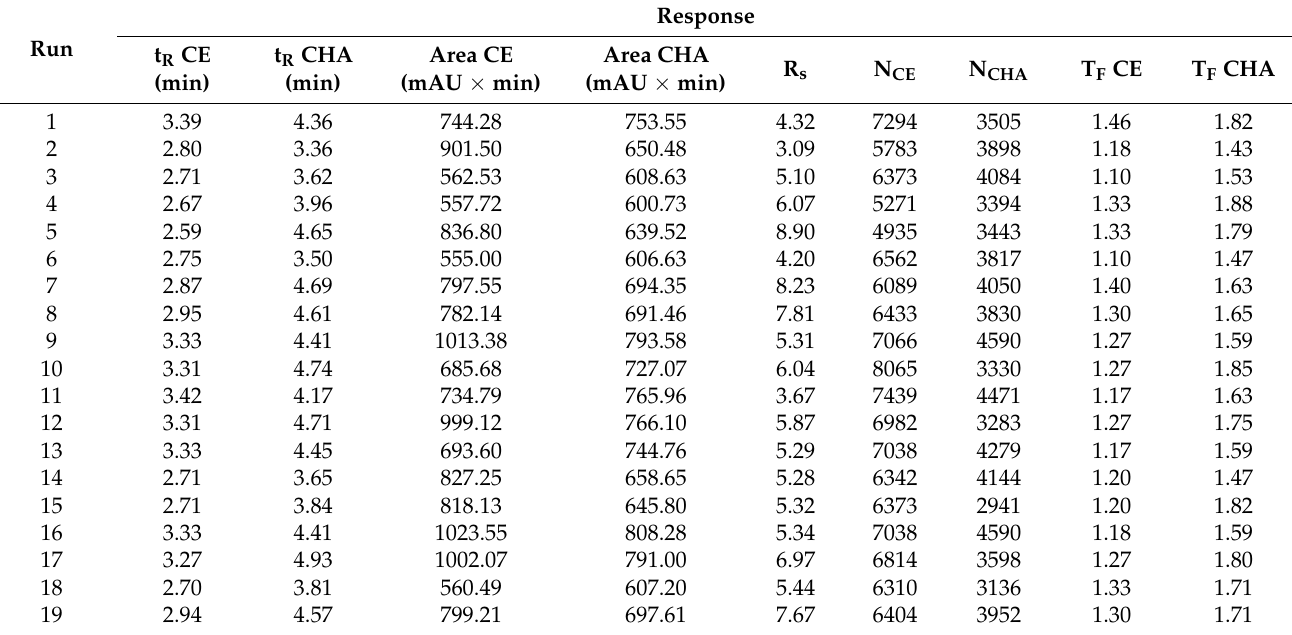
Table 6. Values of the responses after the conduction of the fractional factorial